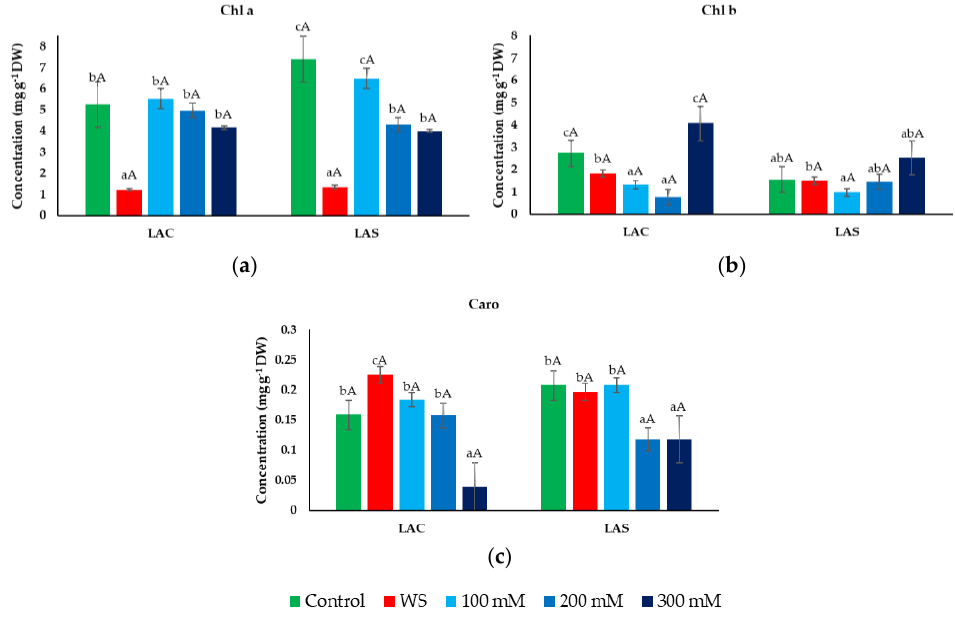
Figure 4. Photosynthetic pigment concentrations under water deficit and salt stress conditions. Leaf contents of chlorophyll a (Chl a) ( a ), chlorophyll b (Chl b) ( b ), and total carotenoids (Caro) ( c ) in L. angustifolia var. ‘Codreanca’ (LAC) and var. ‘Sevtopolis’ (LAS) plants after 30 days of growth under control conditions, in the presence of the indicated NaCl concentrations or subjected to water stress (WS) (completely withholding irrigation). DW, dry weight. Bars represent means ± SE ( n = 5). Di ff erent lowercase letters above the bars indicate significant di ff erences between treatments for each variety, and di ff erent uppercase letters indicate significant di ff erences between the two varieties for plants undergoing the same treatment, according to the Tukey test ( α = 0.05).